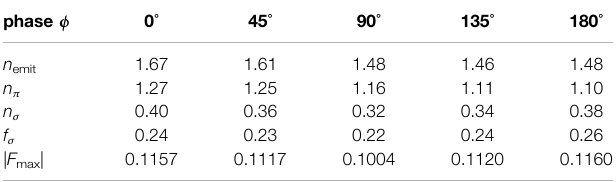
TABLE 1 | Summary over the numerical results obtained from the rtTDDFT calculations. Listed are the number n emit of emitted electrons originating from 3 π and2 π orbitals(HOMOandHOMO-1), n π ,andfrom9 σ and8 σ orbitals(HOMO- 2 and HOMO-3), n σ , as well as the fraction of electrons originating from σ